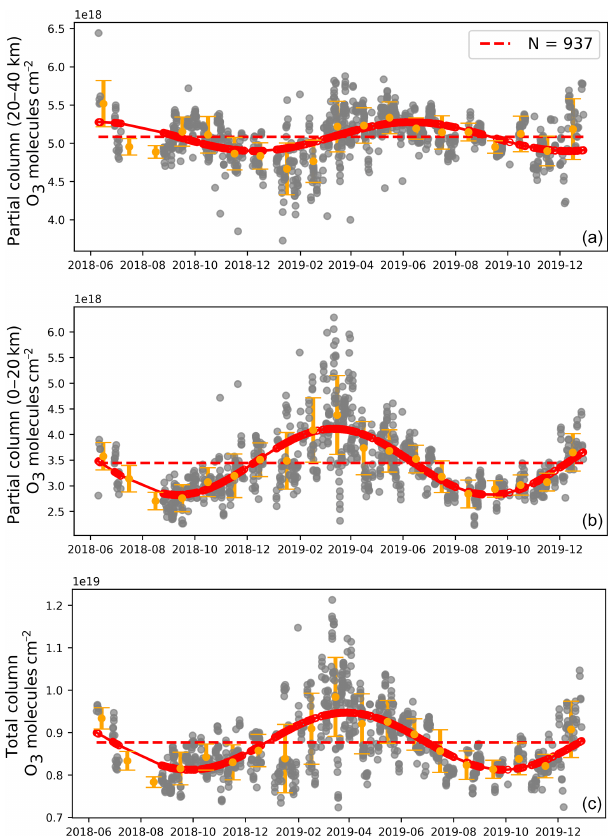
Figure 3. The time series of the FTIR retrieved O 3 total column (c) , as well as the partial column between surface and 20km (b) and the partial column between 20 and 40km (a) from June 2018 to December 2019 at Xianghe. The gray dots are individual retrievals. The orange dots and error bars are the monthly means and SDs. The dashed red line is the mean, and the solid red line is the fitted seasonal variation. N is the measurement